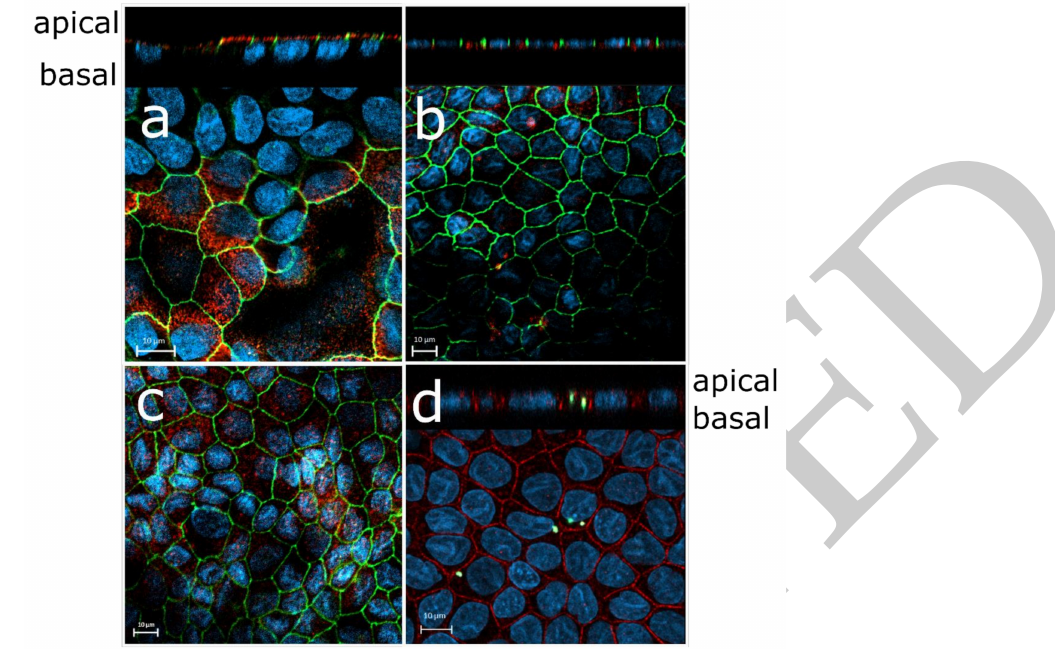
Figure 3. LEPI cells with mature RPE phenotype. Occludin was used in all ( a – c ) images to reveal the cell shape and the presence of tight junctions (green). DAPI stain was used to visualize the cell nuclei (blue). ( a ) Ezrin (red) was detected on the apical surface indicating proper microvilli formation. ( b ) LEPI cells showed RPE-specific BEST1 expression on the basal membrane (red) and ( c ) RPE65 expression in the cytoplasm (red). The cells were cultured 18 days before imaging. ( d ) Confocal microscope image of LEPI cells cultured on Ibidi slides for one week. The cells were exposed to FITC labeled photoreceptor outer segments (FITC-POS, green), and after 20 h incubation, the cells were washed and counterstained with anti-MRP1 antibody (red) localized in lateral plasma membranes. The vertical section view (upper panel) shows internalized FITC-POS in LEPI cells. Scale bars 10 µ m.